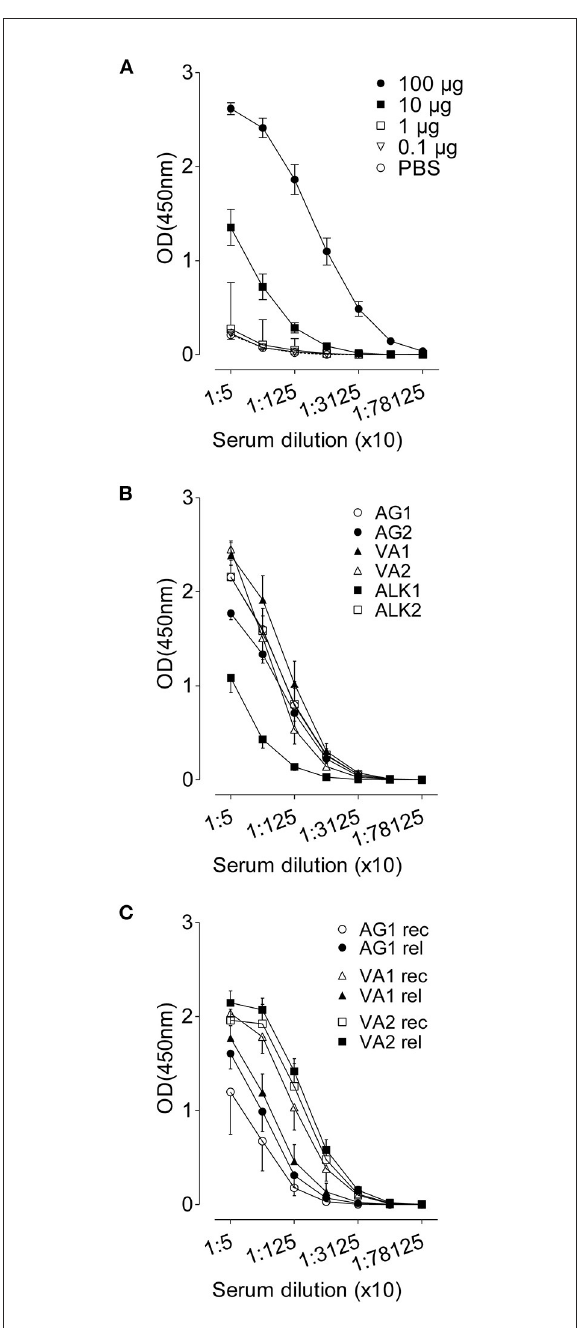
FIGURE8 RWP-specific IgG1 serum titres. Allergen-specific antibody responses against (A) titrated RWP (AG1) doses during acute onset disease, (B) AG1, AG2, ALK1, ALK2, VA1 and VA2 pollen from diverse geographical locations during acute disease onset, and (C) AG1, VA1, VA2 pollen during relapse induction. Data are presented as mean ± SEM [minus PBS control for (B) and (C) ] and are representative of at least two experiments; n = 4–8